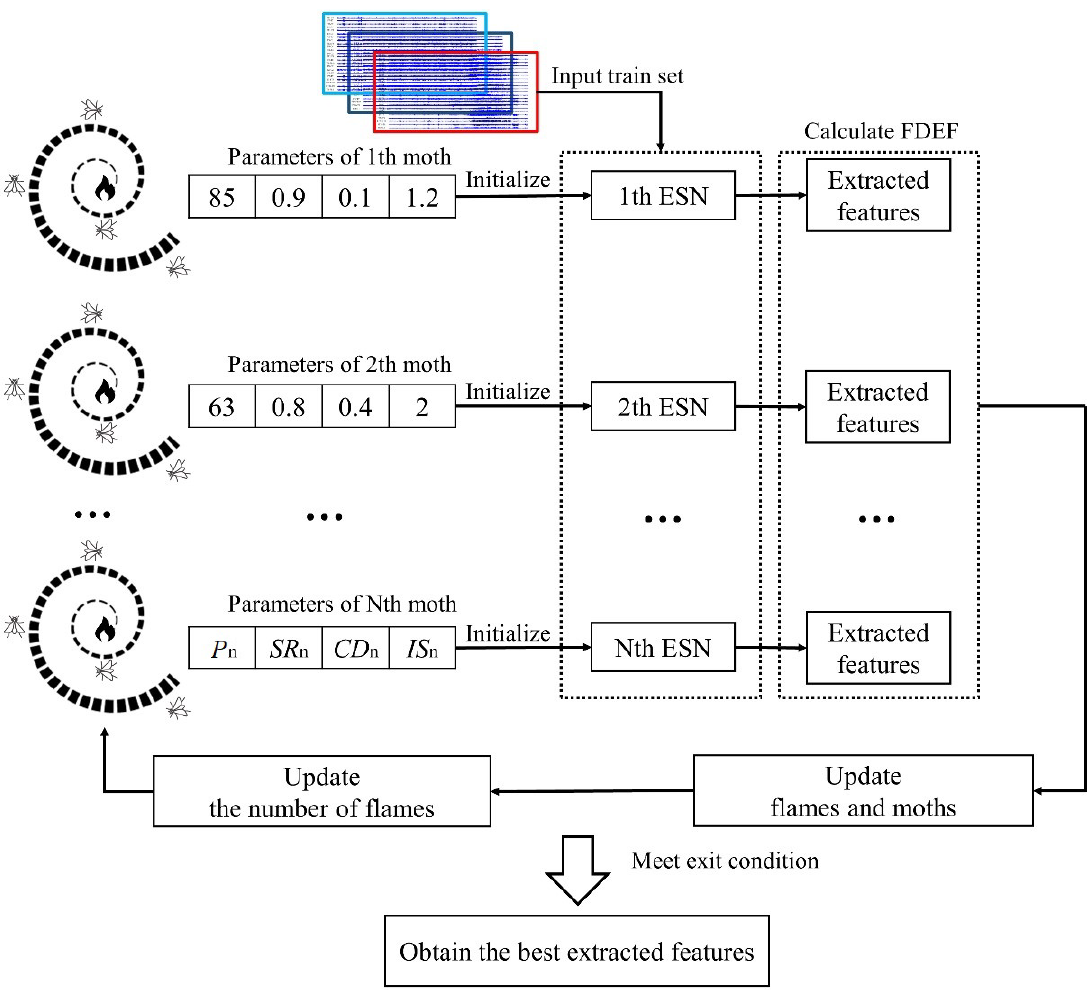
Figure 3. The structure of MFO -ESN.